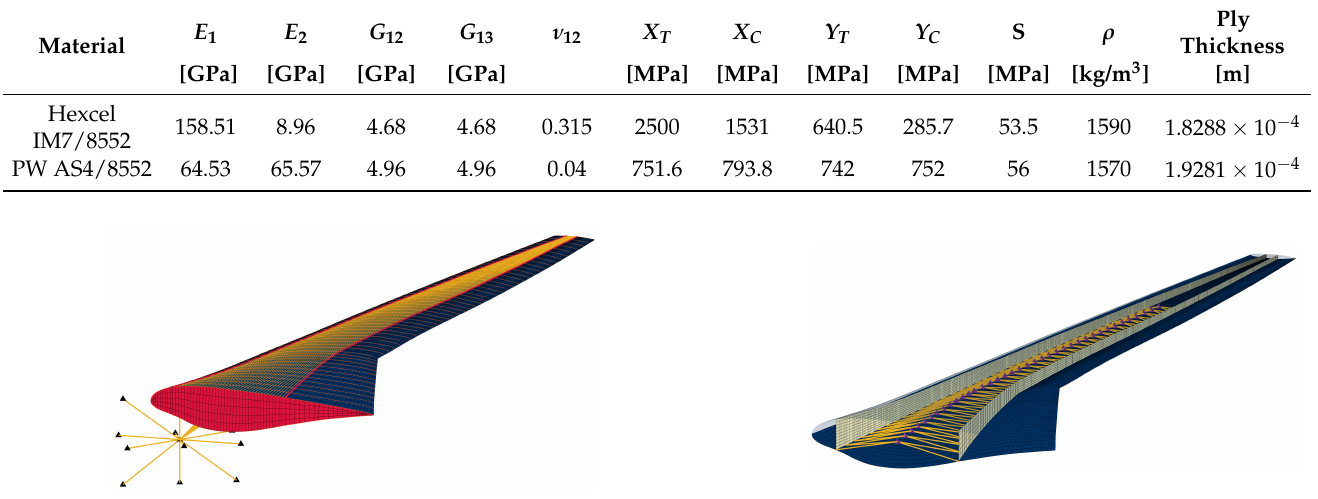
Figure 8. uCRM13.5 wing FEM mesh and fuel distribution detail.